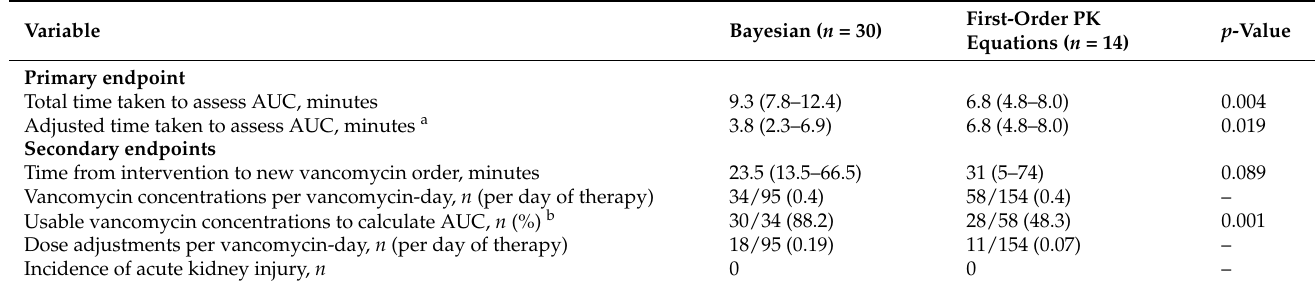
Table 2. Primary and secondary